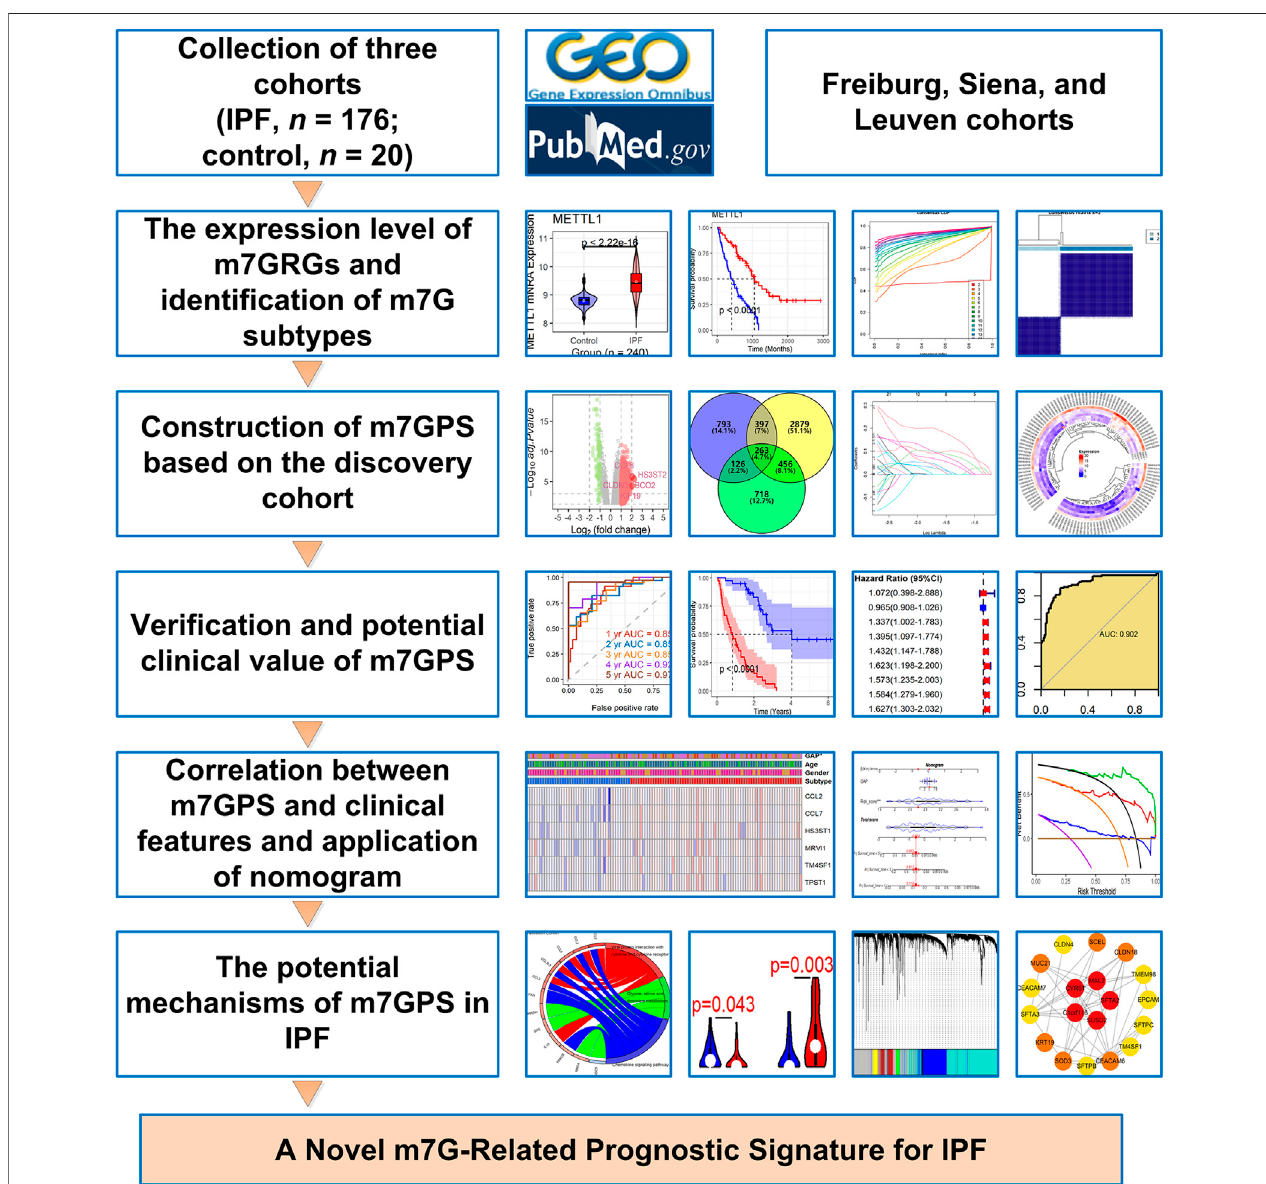
FIGURE 1 | The design and main results of this study. IPF, idiopathic pulmonary fi brosis; m7GPS, m7G-related prognostic signature.